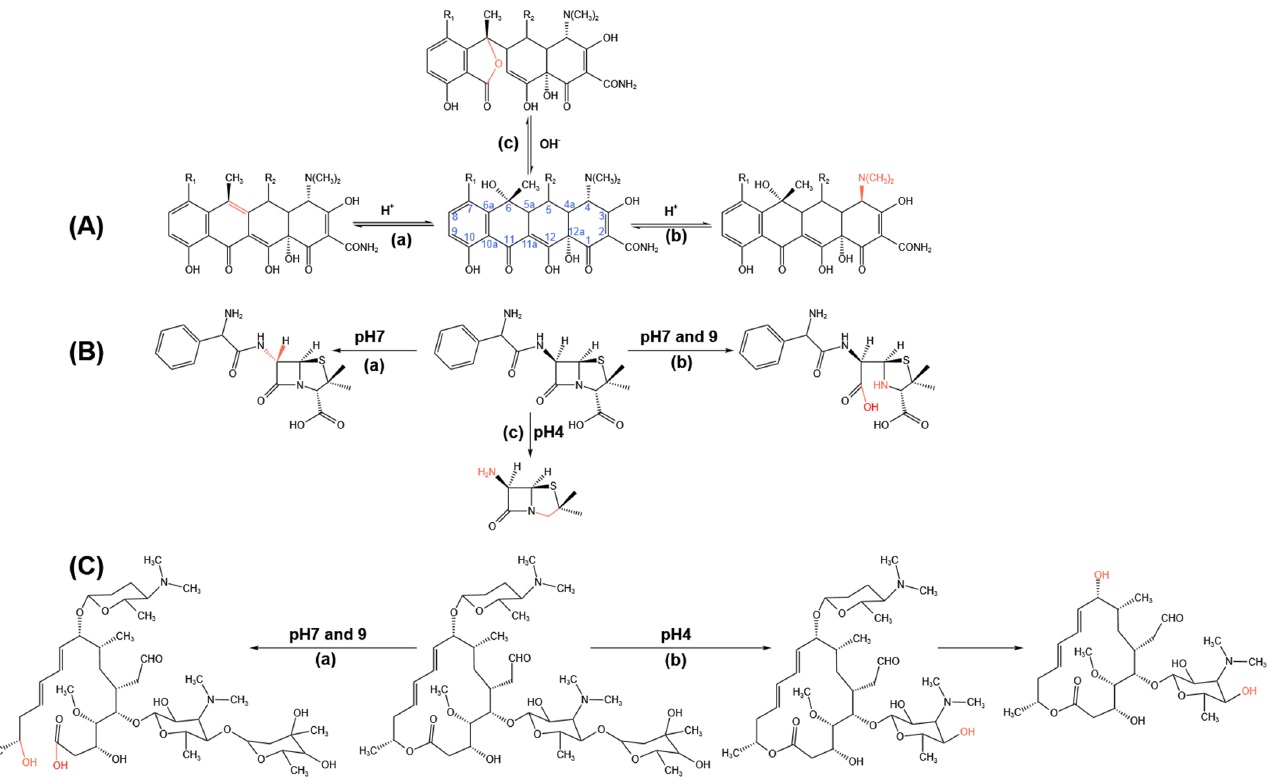
Figure 4. Proposed hydrolysis pathways for ( A ) tetracycline, ( B ) ampicillin, and ( C ) spiramycin according to [71–75].